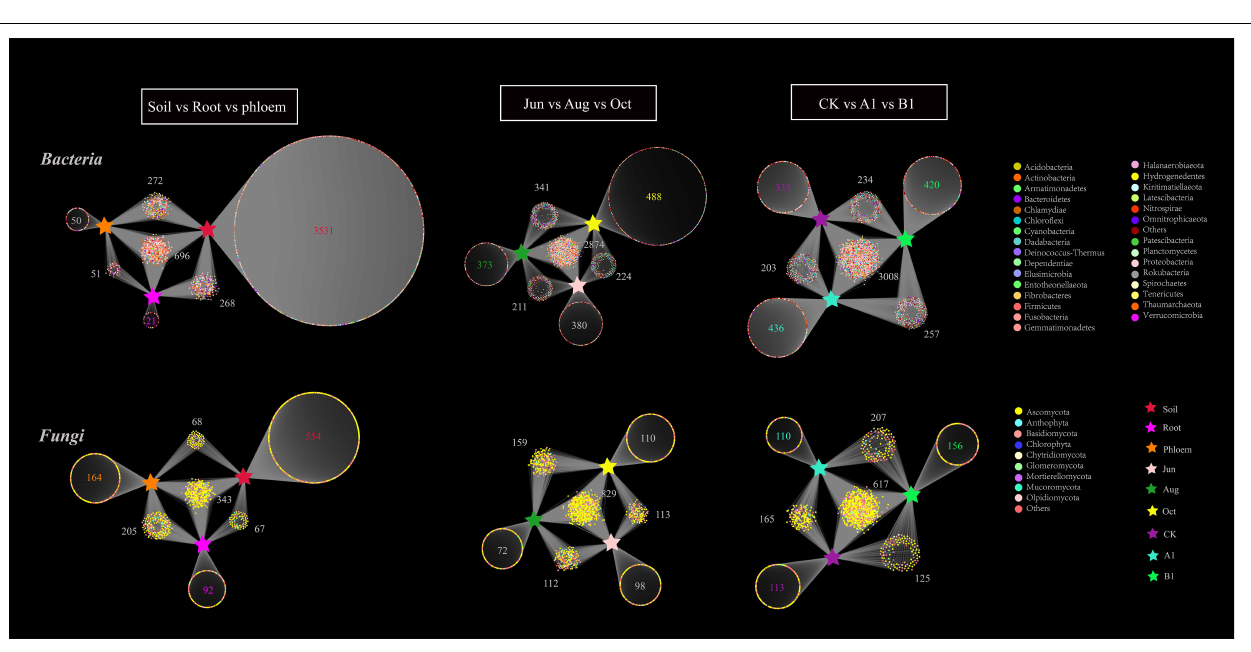
FIGURE 6 | Bipartite association network of both bacterial and fungal communities across the three habitat classifications (soil, roots, and stems), seasons (June, August, and October), and genotypes (CK, A1, and B1). Each circle corresponds to an OTU, and its color represents the OTU annotation of bacteria at the phylum level and fungi at the class level. The stars represent different